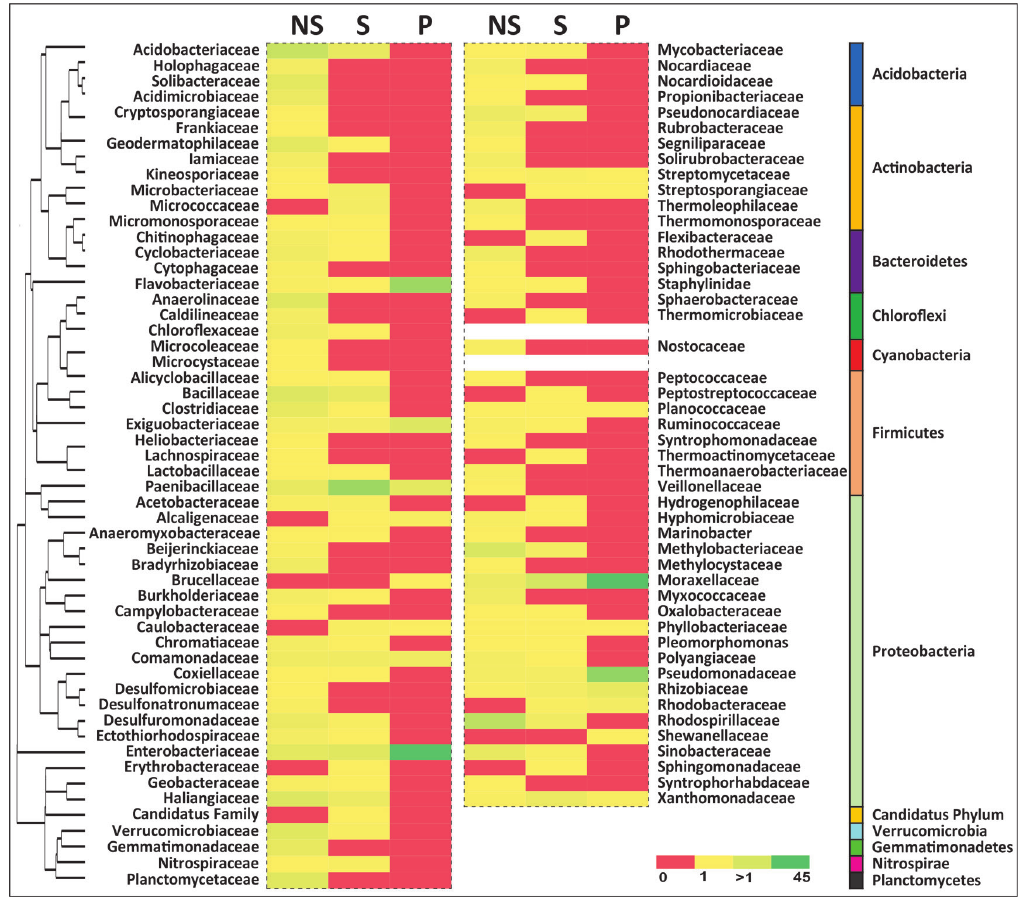
Fig. 2. Heatmap for the family level abundance of root-associated soil microbiome (Database used SILVA123). Abundance in each library shown in the actual number and the clustering of each family-level taxa with dendrogram is derived with the help of farthest neighbour (constrained)